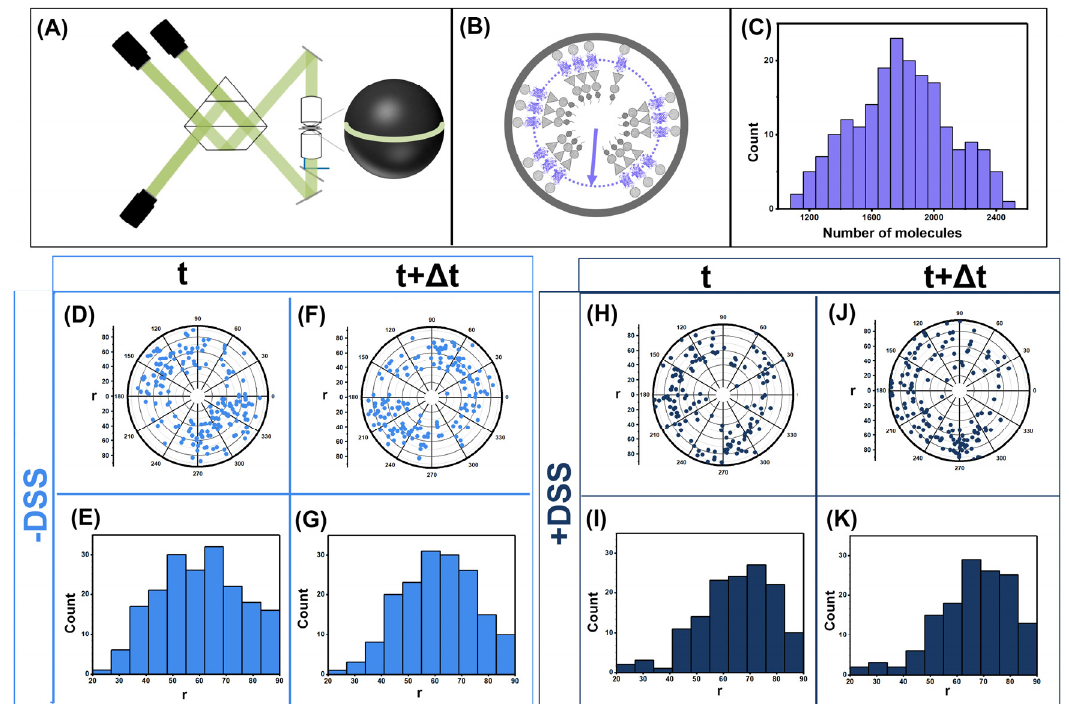
Figure 1. Dynamics of Gag molecules observed by iPALM. HIV Gag(MA-Dendra2-CA) VLPs were produced in HEK293 cells and imaged by iPALM as outlined in text. ( A ) Diagram representation of iPALM. The Gag VLP is shown as a dark sphere, iPALM has 8 nm voxel resolution which allows localization of molecules within the VLP. A 20 nm cross section is shown in green for scale. ( B ) Diagram representation of the position of Dendra2 molecules within the presumed Gag(MA- Dendra2-CA) lattice within the VLP. ( C ) Histogram representation of number of Gag molecules counted in 200 representative VLPs. ( D – G ) shows the position of individual Dendra2 molecules in two consecutive localizations within the same VLP ( ∆ T is 45 min). Significant re-arrangements are visible within the lattice when ( D , F ) are compared. ( E , G ) show a histogram of the radial position of each Dendra2 molecule localized within the VLP shown in ( D , F ) with respect to the center of the VLP (demonstrated by arrow in panel B). ( H – K ) show a similar VLP as in ( D – G ), except in the presence of DSS which is a membrane permeable cross linker. Significant lower dynamics are observed in ( H , J ) in the presence of